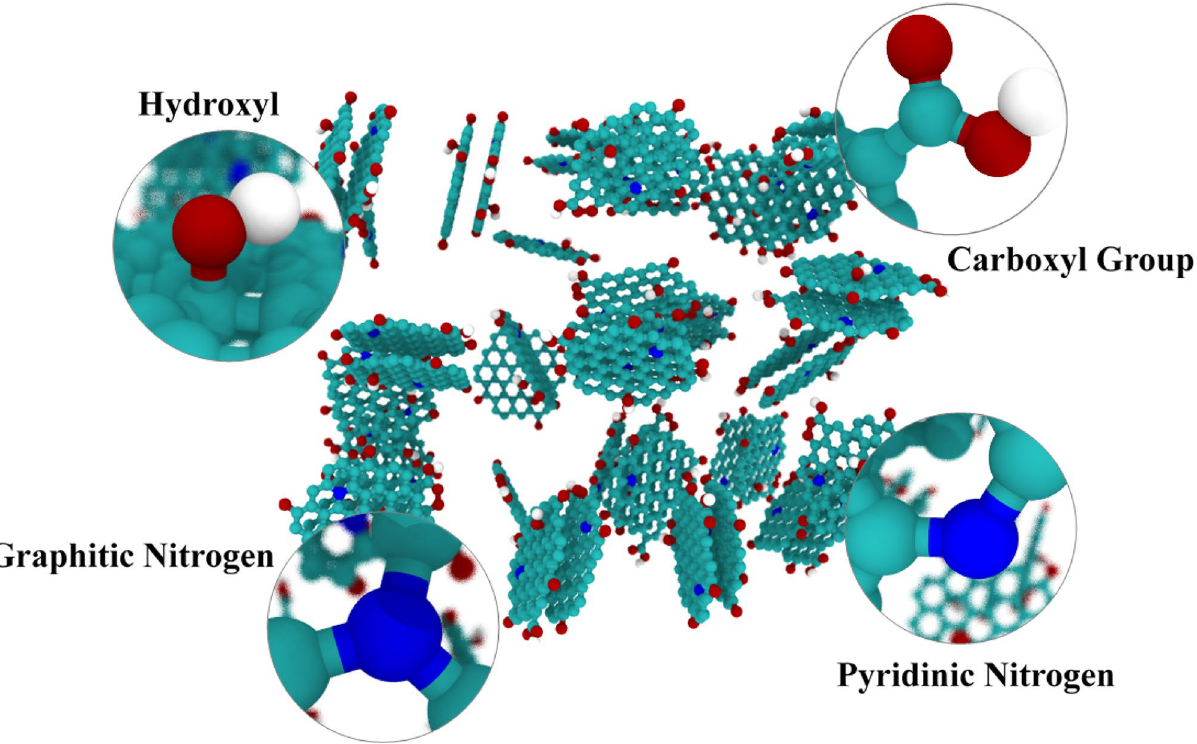
Figure 2. Schema of the groups involved in the molecules